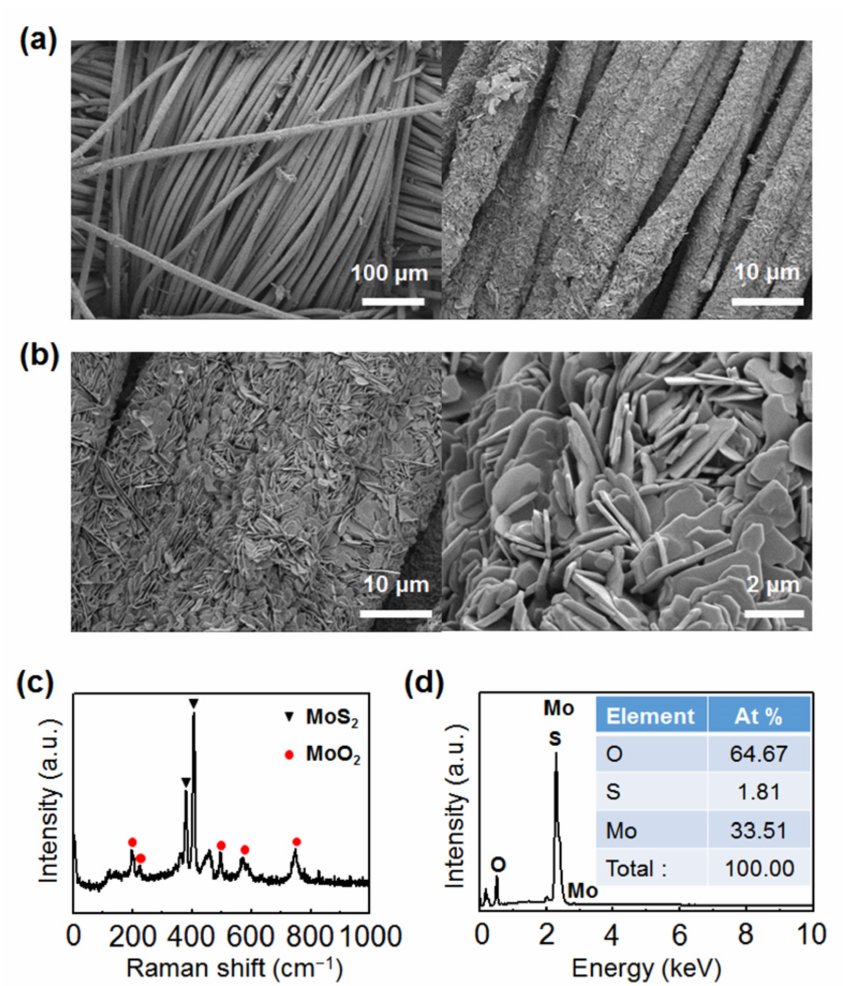
Figure 3. MoO 2 -MoS 2 nanoplates grown on carbon cloth after carbon cloth-assisted CVD growth. ( a , b ) Low-magnification and high-magnification scanning electron microscopy (SEM) images of MoO 2 -MoS 2 nanoplates grown on carbon cloth after the carbon cloth-assisted CVD growth. ( c ) Raman spectrum of MoO 2 -MoS 2 nanoplates. ( d ) SEM–energy-dispersive X-ray spectroscopy (SEM–EDS) data of MoO 2 -MoS 2